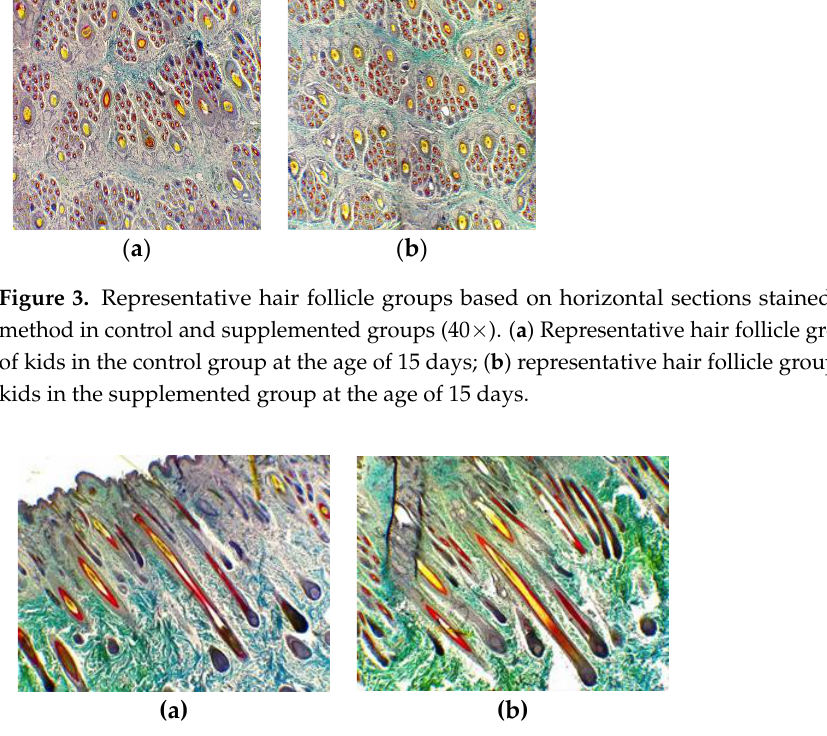
Figure 4. Representative hair follicle groups based on longitudinal sections stained via the Sacpic method in control and supplemented groups (40×). ( a ) Representative hair follicle groups in the skin of kids in the control group at the age of 15 days; ( b ) representative hair follicle groups in the skin of kids in the supplemented group at the age of 15 days. Table 8. Effect of supplementary feeding on hair follicle development.